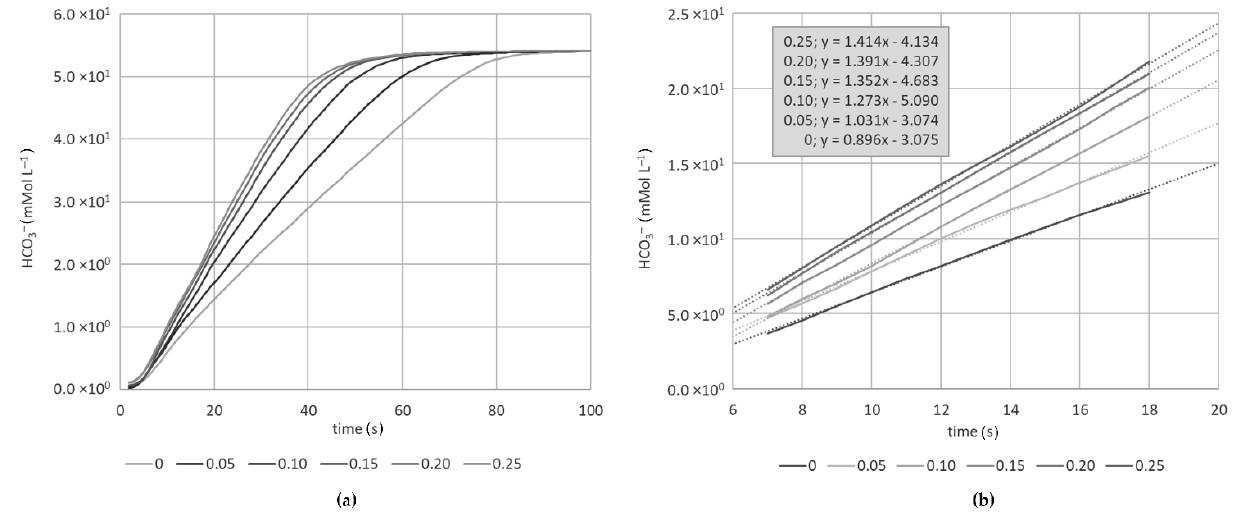
Figure 3. ( a ) Calculated course of HCO 3 − concentration from pH data utilizing Equation (9) at different enzyme concentra- tions (0 to 0.25 mg L − 1 ) and ( b ) data evaluation through the calculation of the incline by the corresponding linear trendlines.